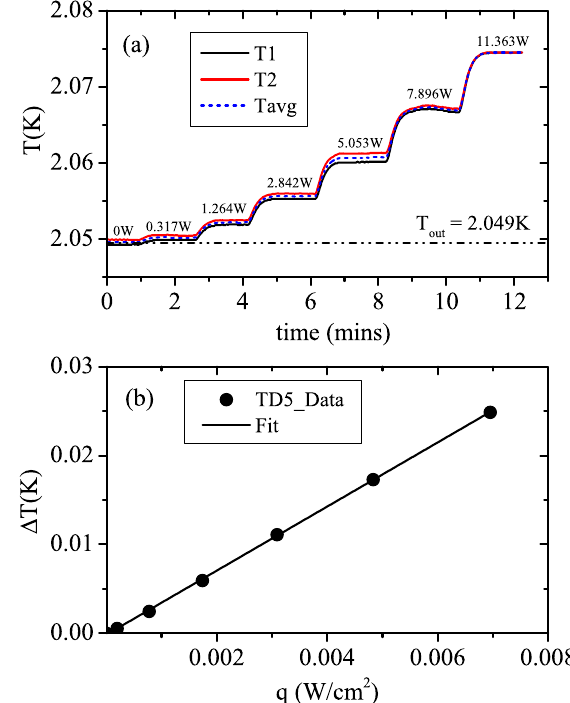
FIG. 2. Typical experimental data measured. (a) The increase in temperature of superfluid He inside the cavity as a function of applied power at 2.05 K and (b) the plot of Δ T vs q for cavity TD5. The slope of the fit gives the thermal resistance at 2.05